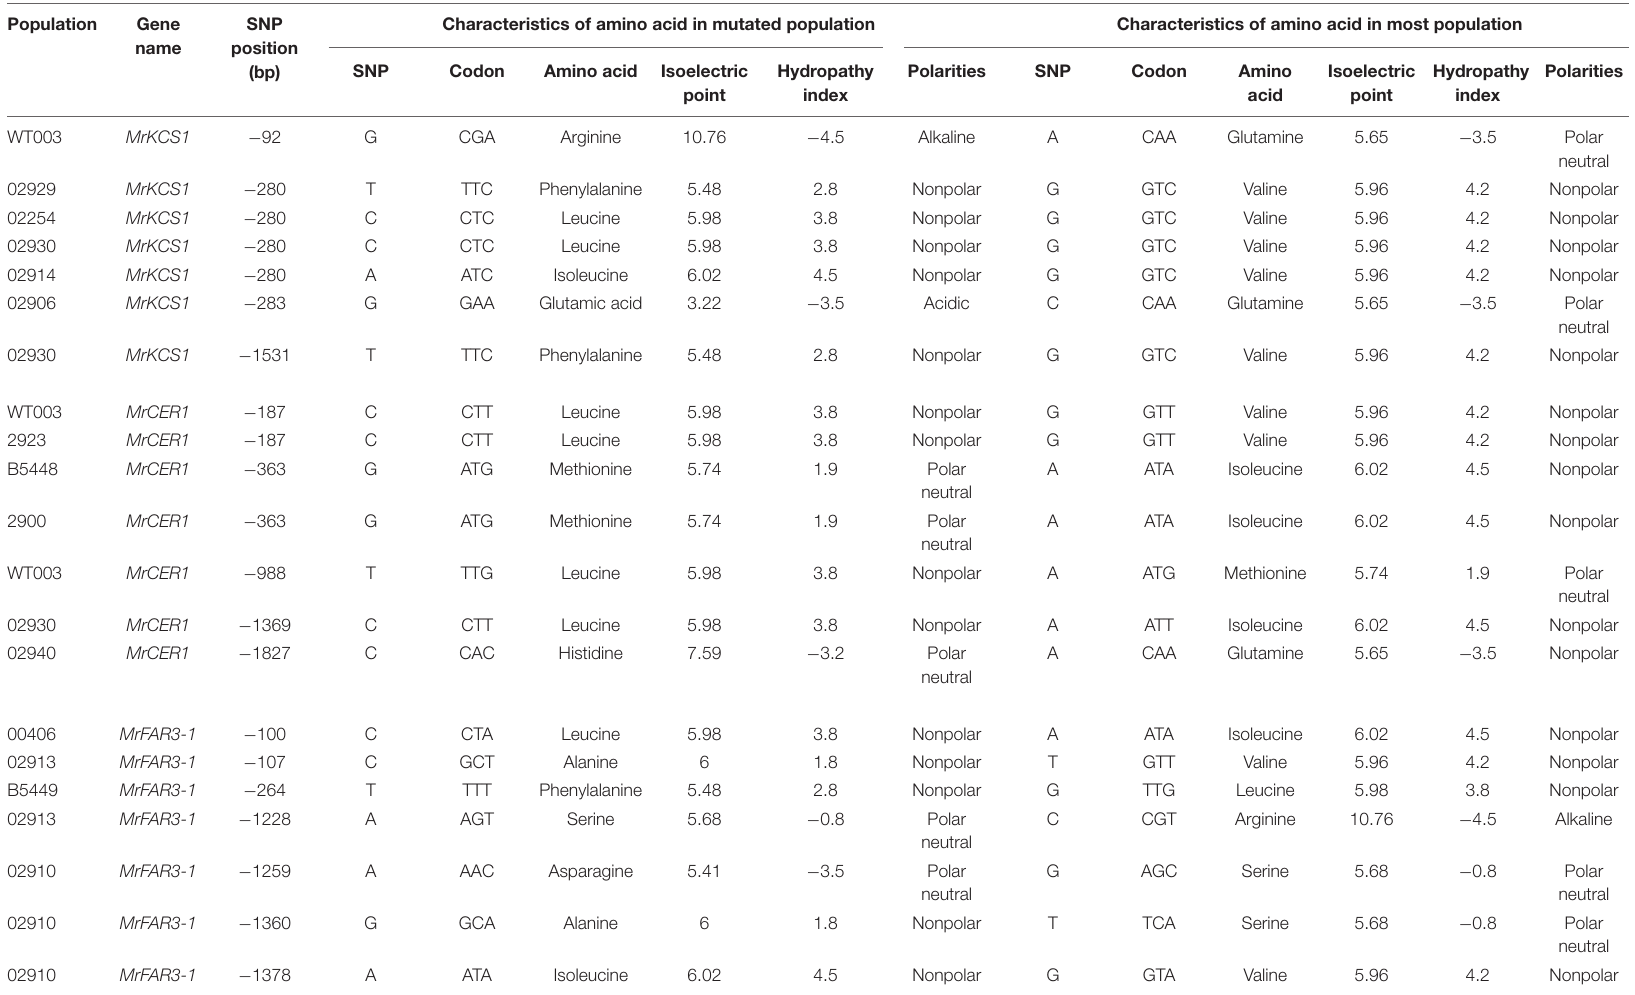
TABLE 3 | Selected missense mutations observed in coding sequences of wax genes in Medicago ruthenica (detailed mutations could be obtained in Supplementary Excel 1 ).